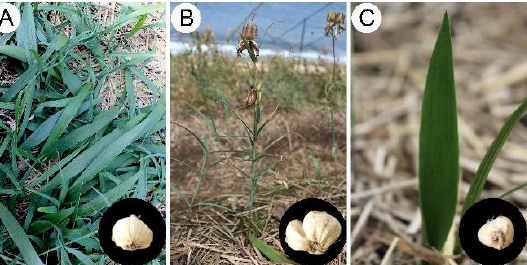
Figure 2. The morphological characters of the aerial parts and dried bulbs of Fritillaria cirrhosa at different growth years. ( A ) Four-year stages (FY); ( B ) six-year stages (SY); ( C ) six-year stages appeared phenotype variation (ASY).